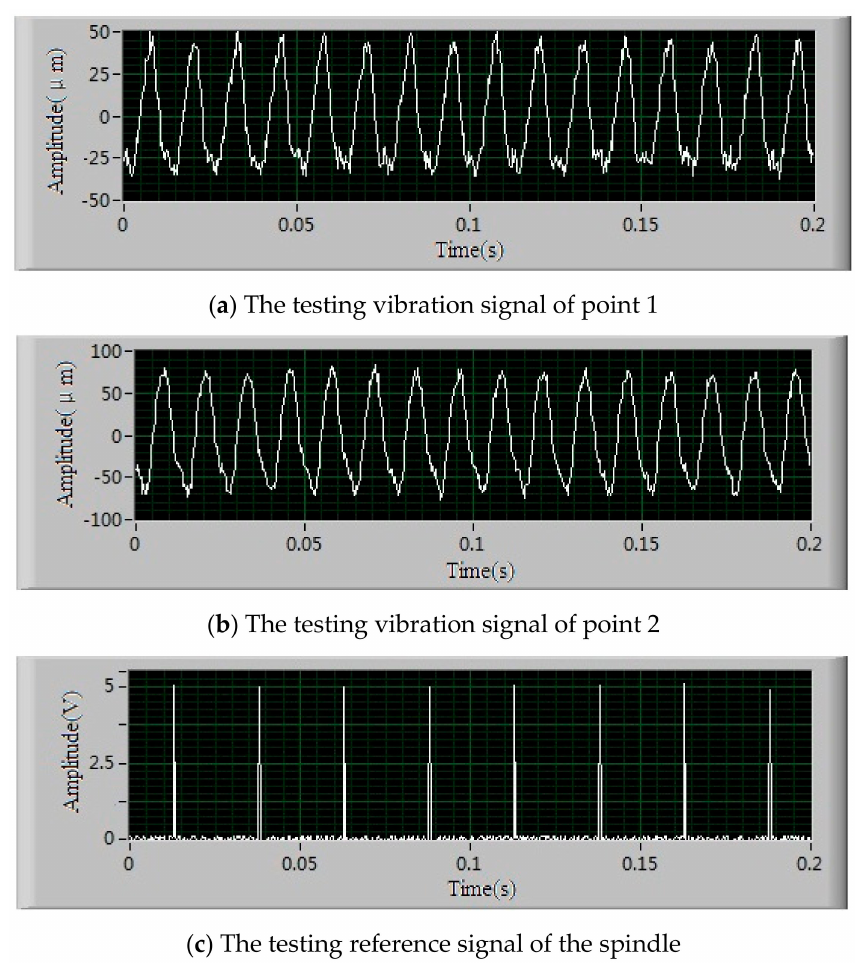
Figure 10. The original vibration signals and reference signal of the spindle after the first trial weight. The unbalance vibration signals separated from the signals in Figure 10 are listed as